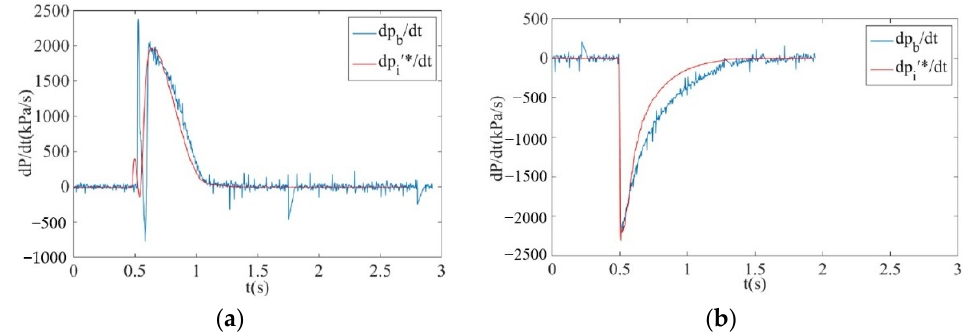
Figure 19. Comparison diagram of actual value and measured value of the pressure change rate during the inflation process and deflation process of the brake chamber. ( a ) Measurement curve of the brake pressure change rate during inflation process. ( b ) Measurement curve of the brake pressure change rate during deflation process.